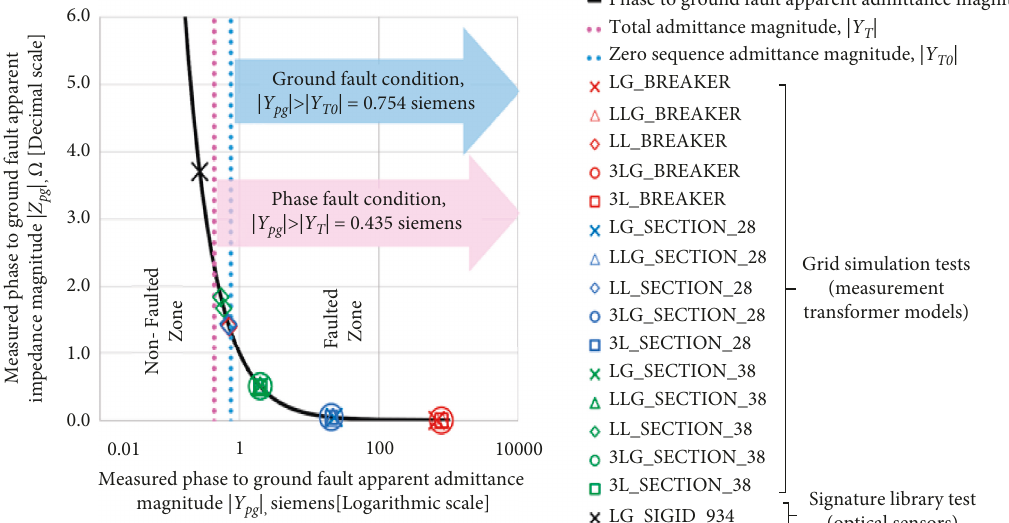
Figure 7: Measured PGFA admittance magnitudes for the fault states.